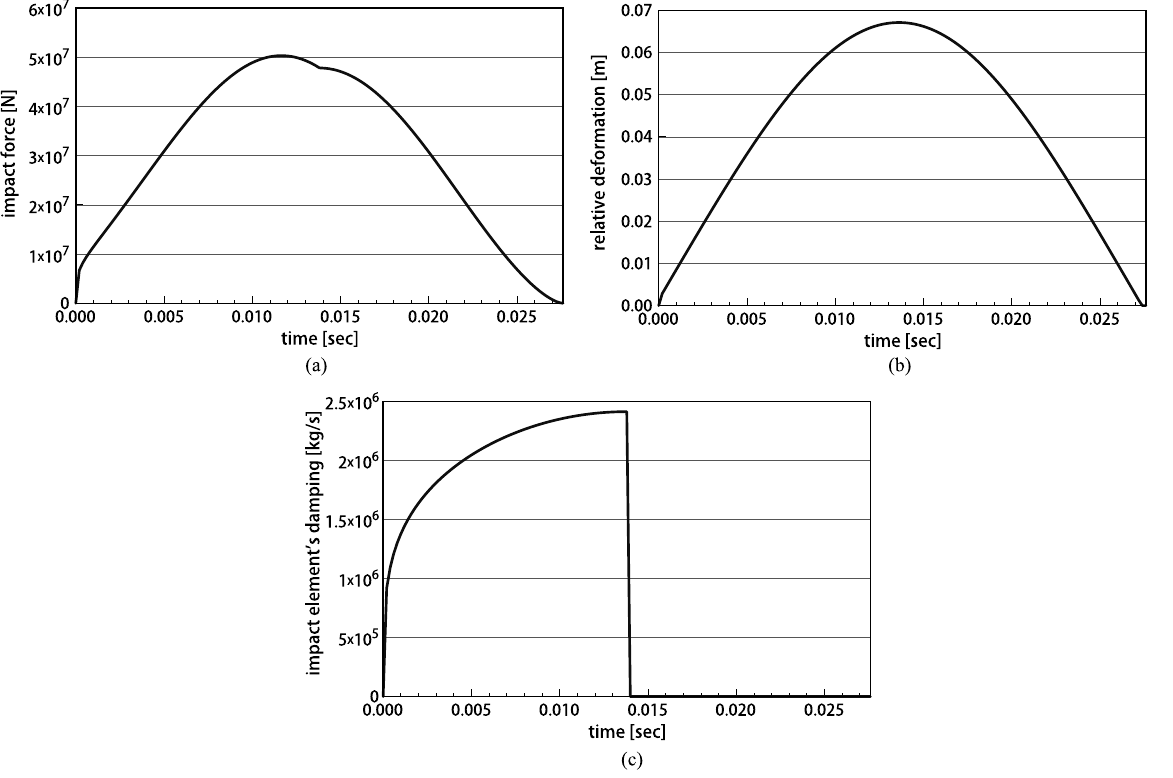
Fig. 14. Time histories during impact: (a) impact force; (b) relative vertical deformation of colliding structural members; (c) impact element’s